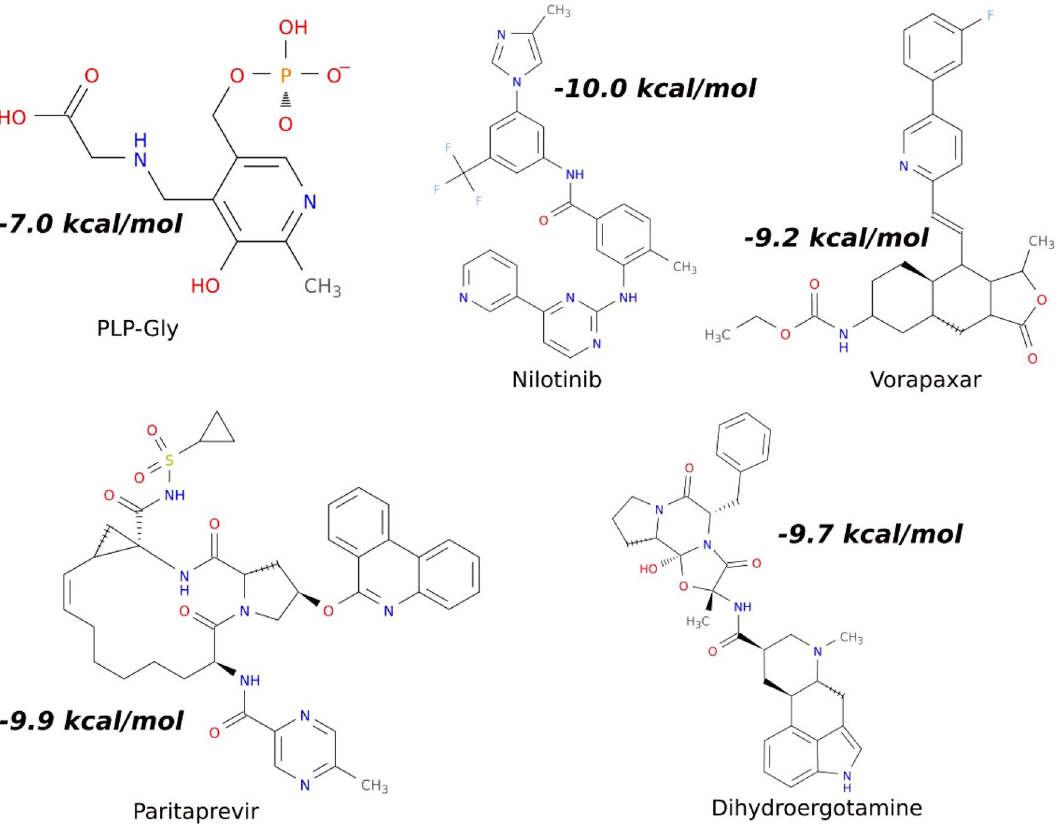
Figure 6. Chemical structures of the selected drug candidates and their autodock binding energies. The binding energy of the natural substrate, PLP-Gly, is also shown.